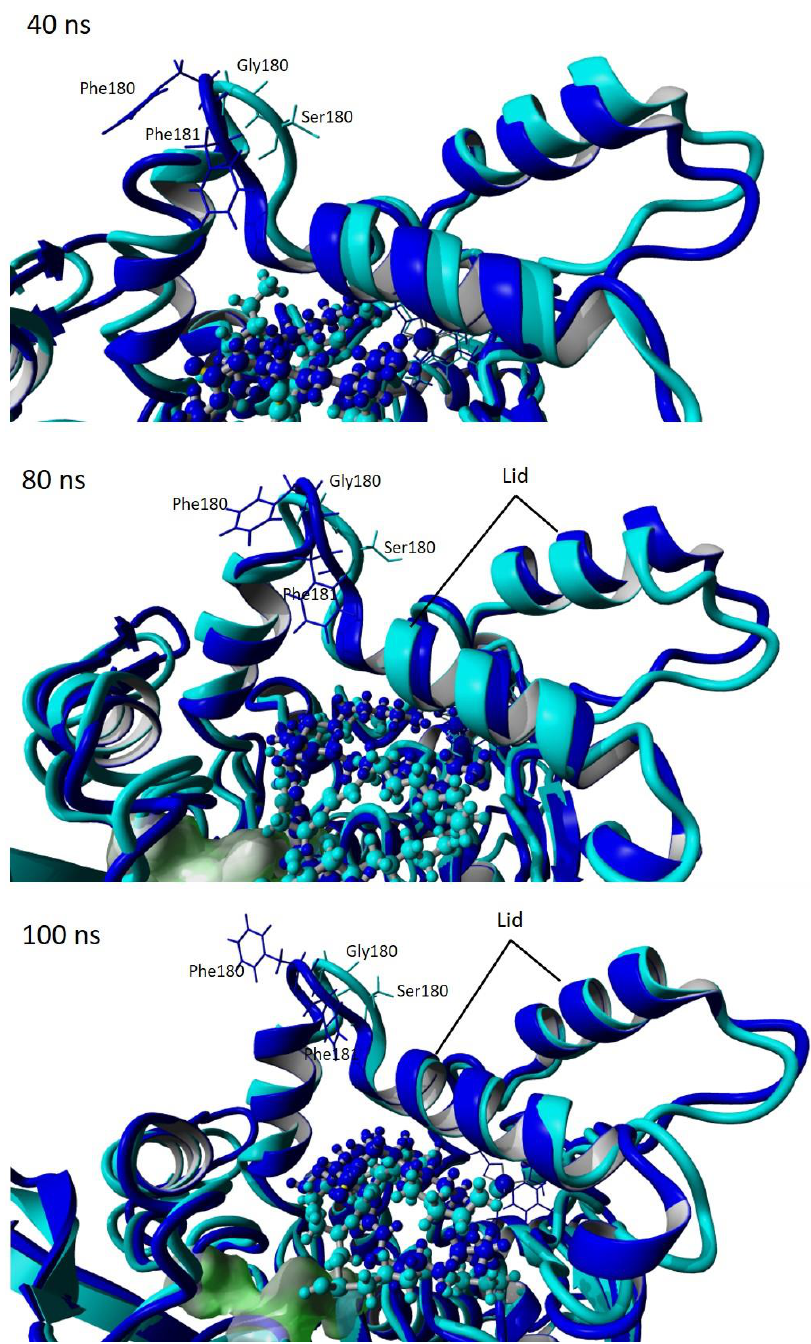
Figure 10. Snapshot of simulation trajectories at 40, 80 and 100 ns of wt-T1 and 3M variant lipases showing the motion of the lid. Cyan represents the 3M variant. Blue represents the wt-T1.